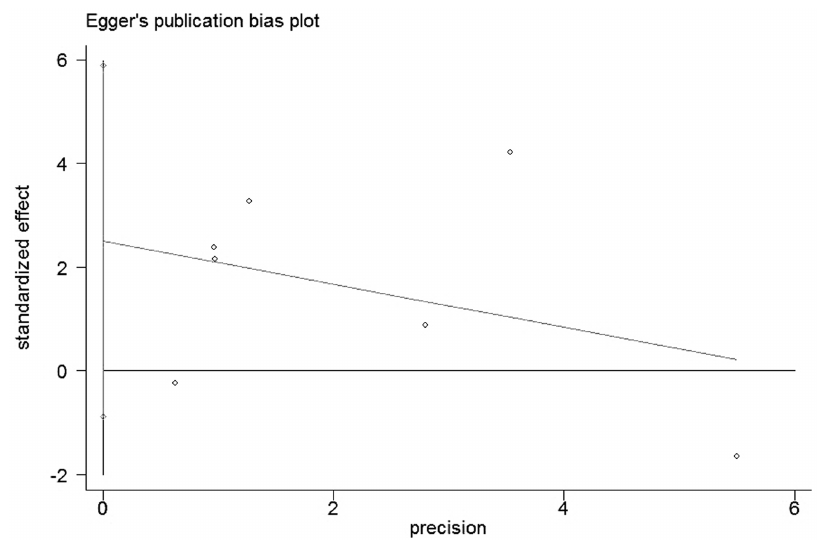
Figure 5. Sensitivity analysis of all the studies assessing OS.